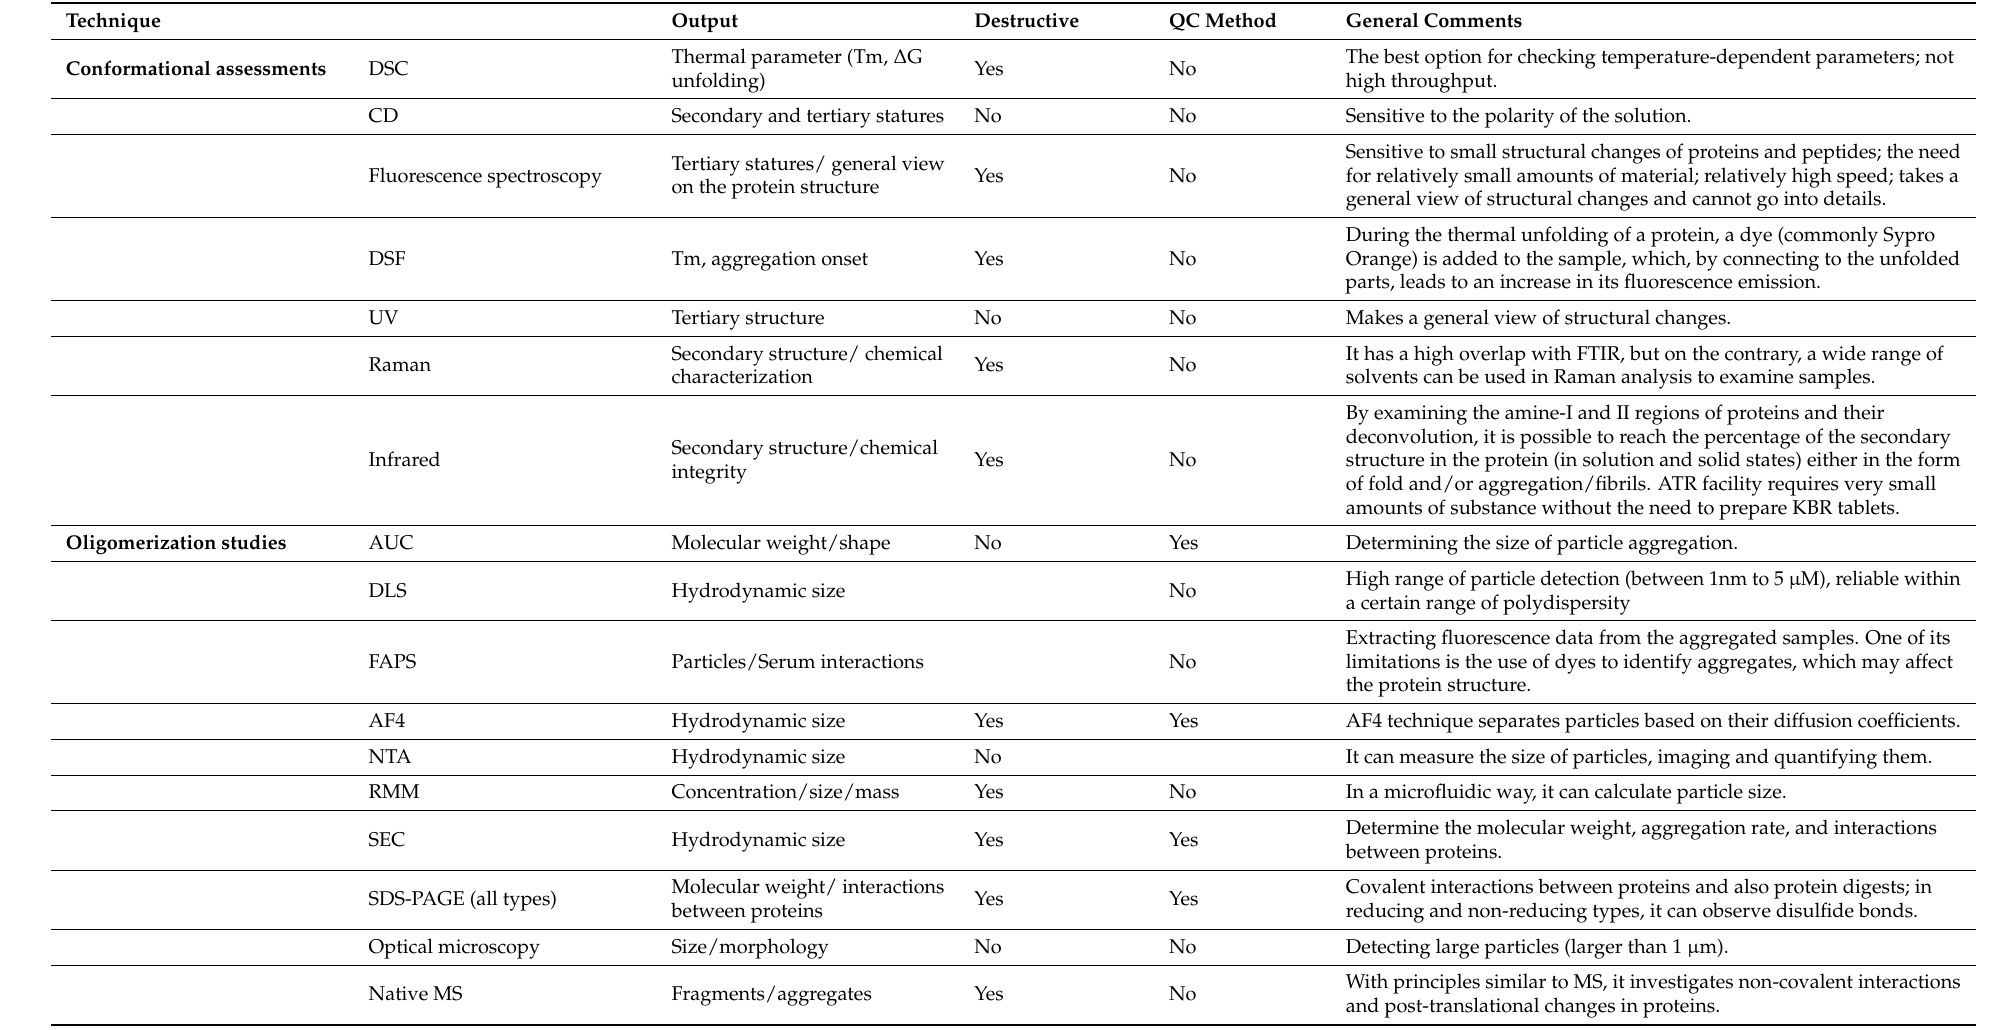
Table 7. The list of analytical techniques to characterize medicinal proteins and peptides [39,253,264,265].